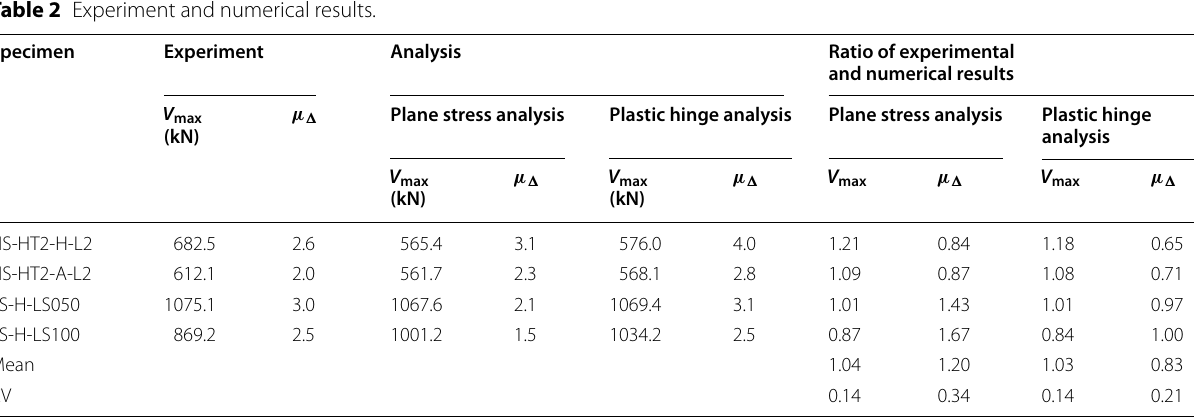
Table 2 Experiment and numerical